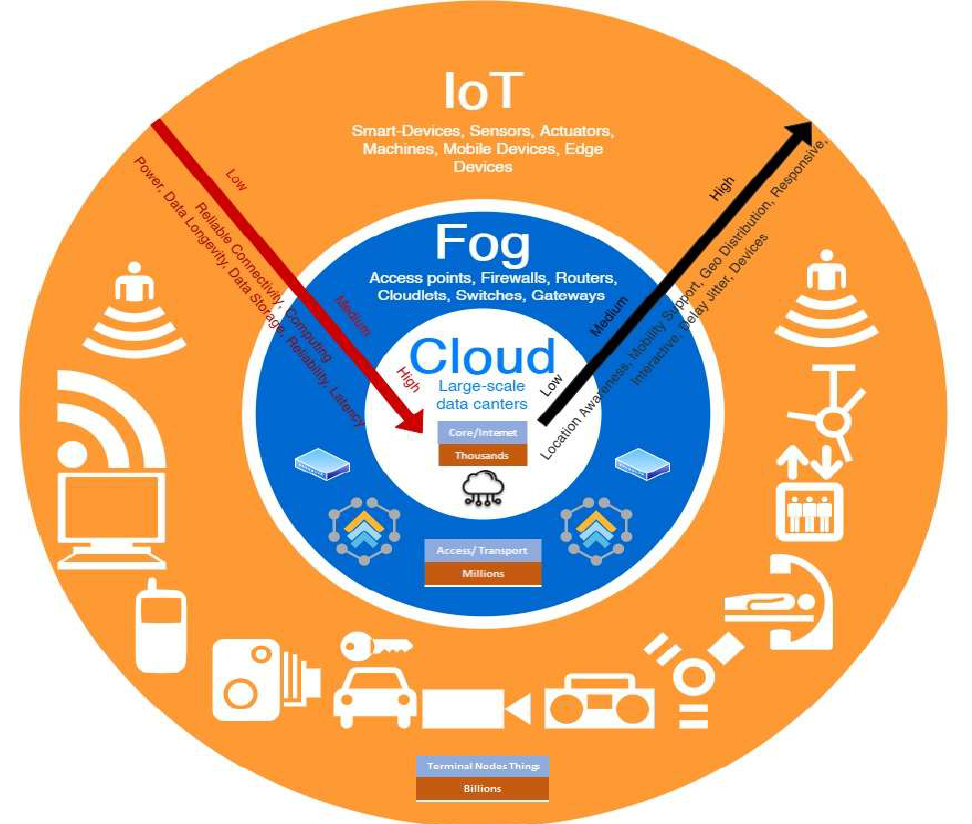
Figure 1. Three-layer architecture for IoT–fog–cloud (IFC) ecosystem. Table 1. Consensus Protocol. PoW—proof of work; PoS—proof of stake; PoET—proof of elapsed time; BFT—Byzantine fault tolerant.